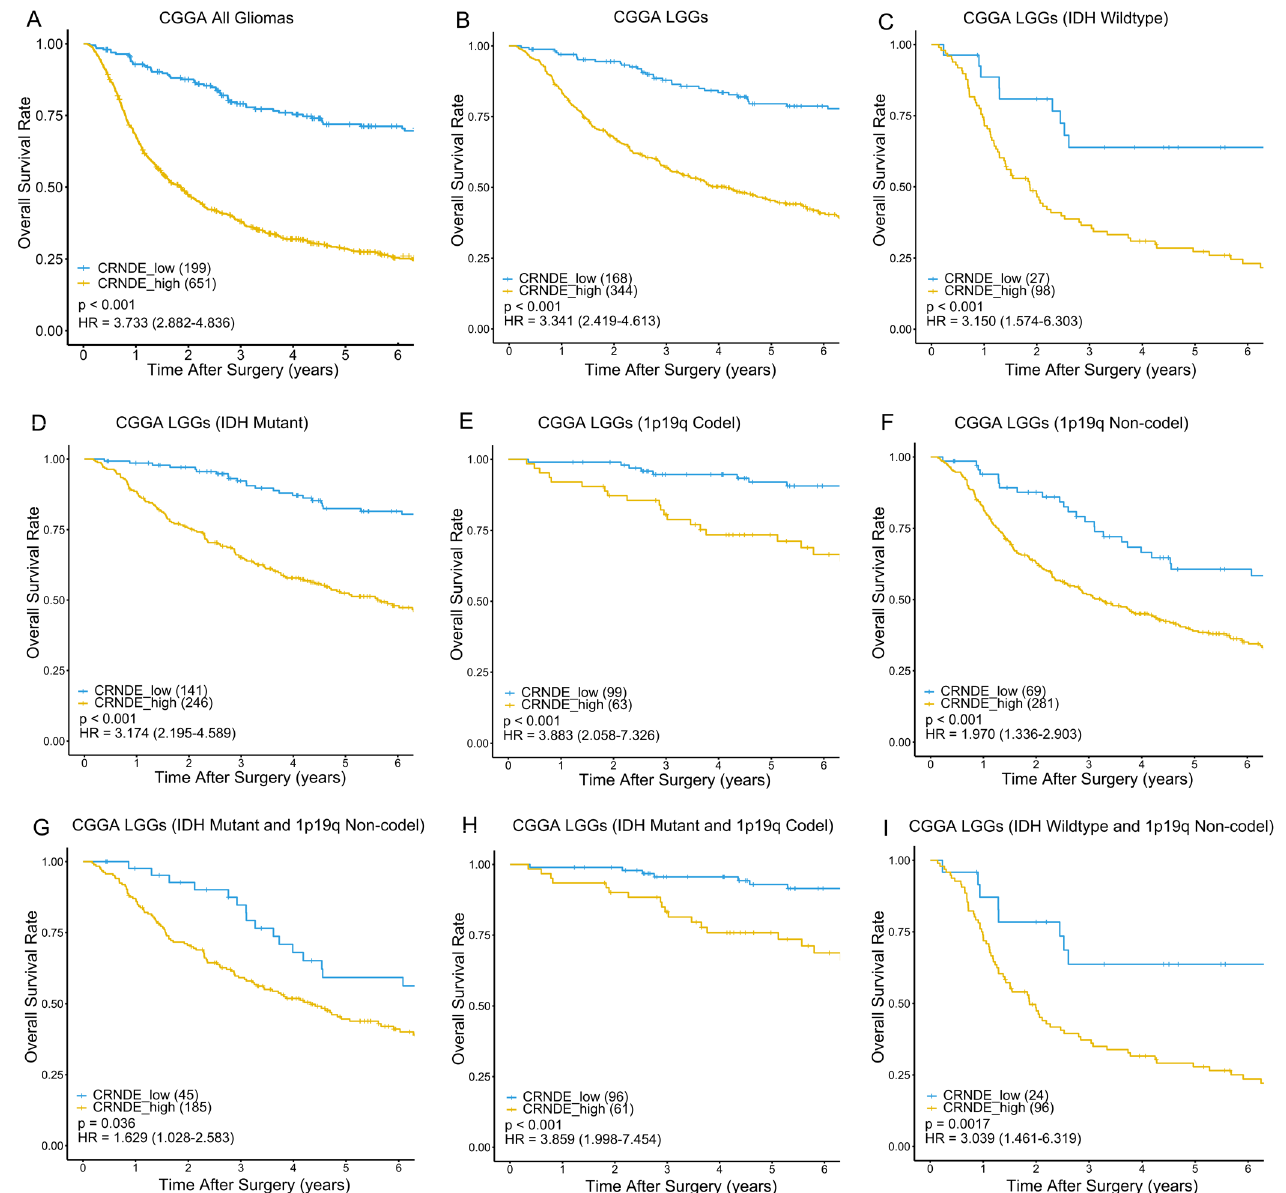
Figure 3. Kaplan–Meier survival curves of the high- and low-expression groups according to IDH and 1p19q status in CGGA dataset. Kaplan–Meier survival analyses were performed on ( A ) 850 glioma patients, ( B ) 512 LGG patients, ( C ) 125 patients with wildtype IDH, ( D ) 387 patients with IDH mutation, ( E ) 162 patients with 1p19q codeletion, ( F ) 350 patients without 1p19q codeletion, ( G ) 230 patients with IDH mutation and without 1p19q codeletion, ( H ) 157 patients with IDH mutation and 1p19q codeletion, ( I ) and 120 patients with wildtype IDH and without 1p19q codeletion.